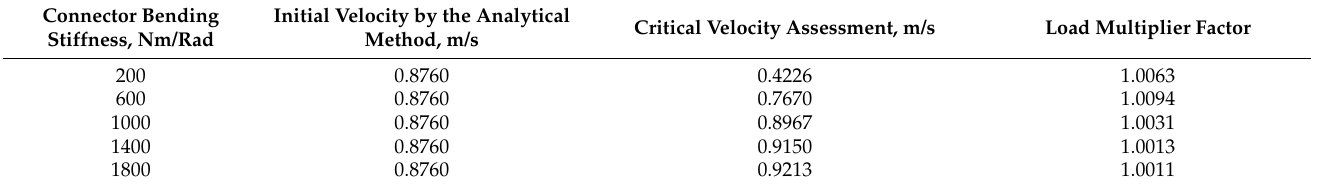
Table 7. The effect of the connector’s bending stiffness on the critical velocity, for the Drift